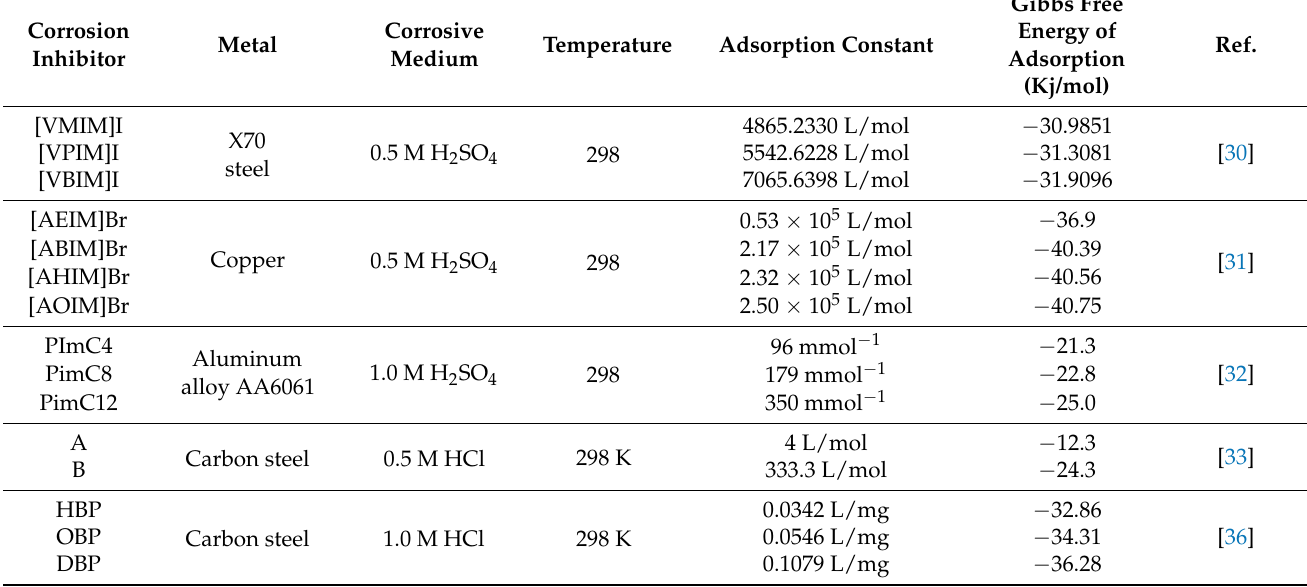
Table 5. Statistical table of Gibbs free constants of corrosion